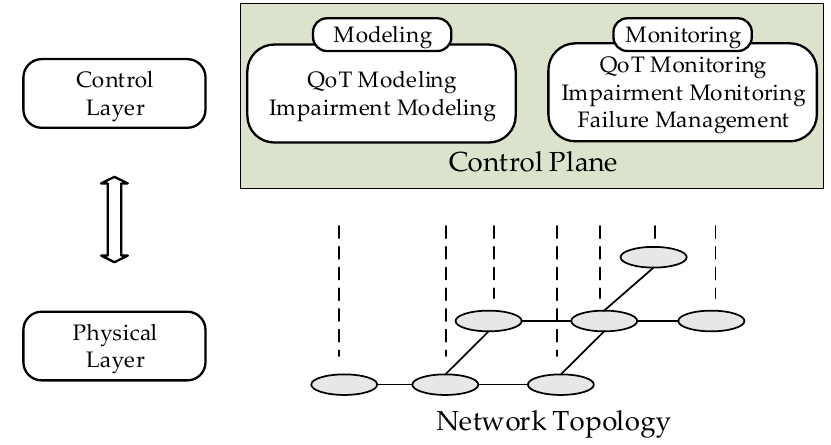
Figure 1. Applications of modeling and monitoring techniques in optical networks.